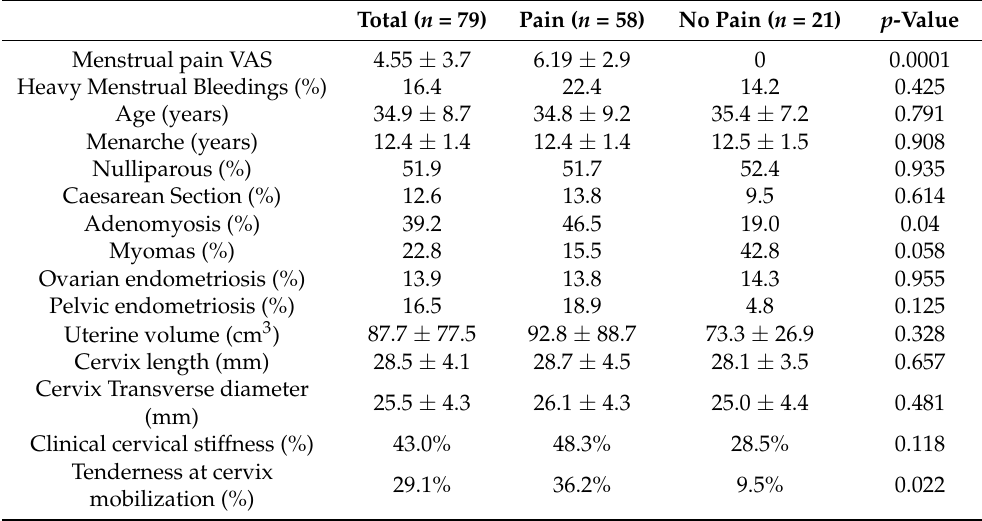
Table 1. Mean ( ± SD) values of enrolled women, also divided at post hoc analysis in women with and without menstrual pain. Significance of comparison between the two groups is reported.